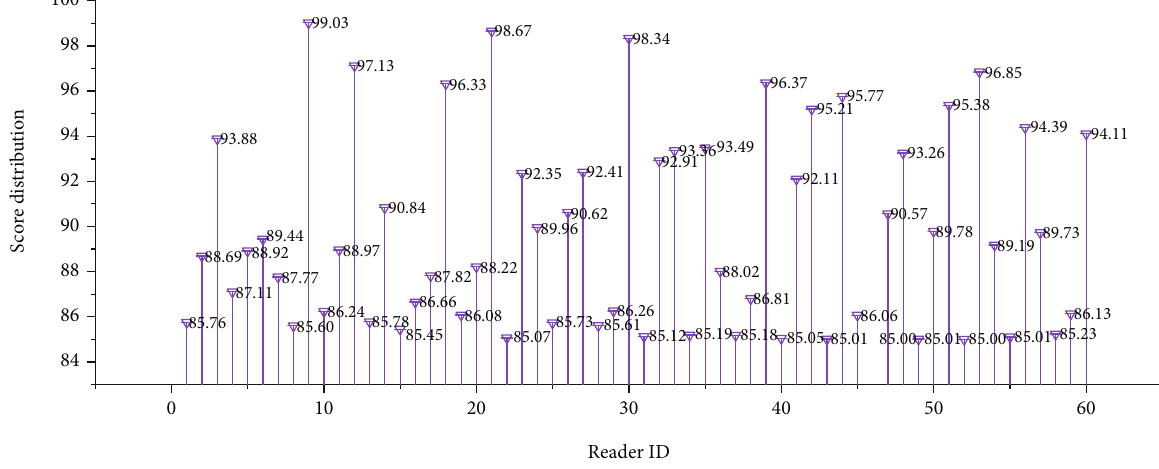
Figure 2: The distribution of emotional scores of readers before reading Japanese literature.